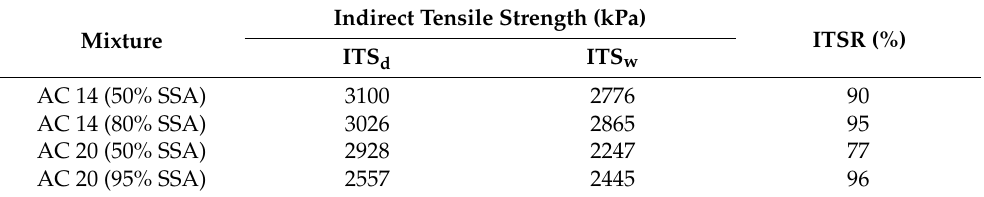
Table 6. Water sensitivity test results of the preliminary asphalt mixtures with